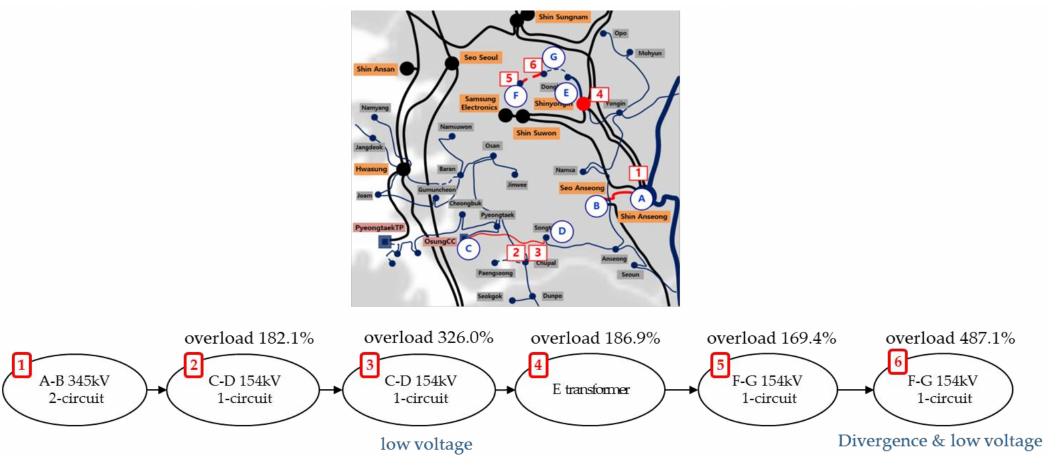
Figure 3. Cascading progression at loading level